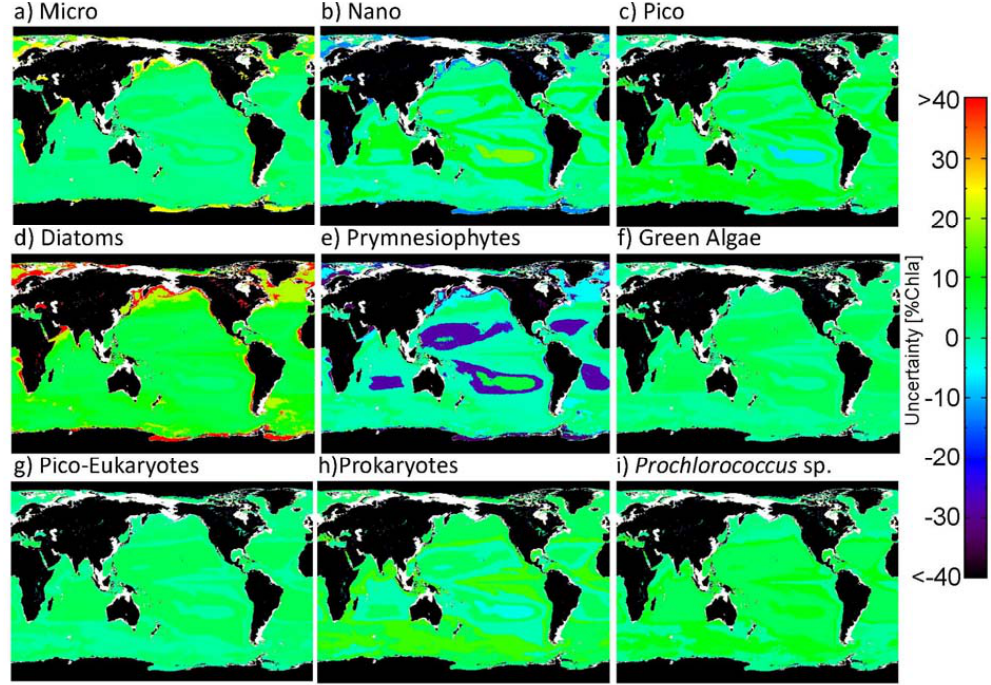
Fig. 6. Spatial distribution of uncertainty in the algorithm estimated for PSCs (a–c) and PFTs (d–h) ; (a) Microplankton, (b) Nanoplankton, (c) Picoplankton, (d) Diatoms, (e) Prymnesiophytes, (f) Green algae, (g) Pico-Eukaryotes, (h) Prokaryotes, (i) Prochlorococcus Fig. 6 Spatial distribution of uncertainty in the algorithm estimated for PSCs (a-c) and PFTs 3 (d-h); a) Microplankton, b) Nanoplankton, c) Picoplankton, d) Diatoms, e) Prymnesiophytes 4 (Haptophytes), f) Green Algae, g) Pico-eukaryotes, h) Prokaryotes, i) Prochlorococcus sp. 5 Haptophytes? 6